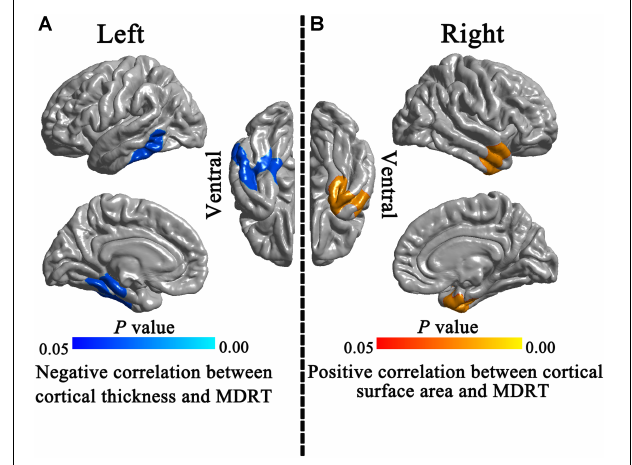
FIGURE 5 | Correlations between morphological indices and MDRT. In the Post-RT patients group, significant negative correlation was observed between the MDRT and the cortical thickness of the left temporal lobe (A) . A significant positive correlation was observed between ipsilateral MDRT and the surface area of the right temporal pole (B)